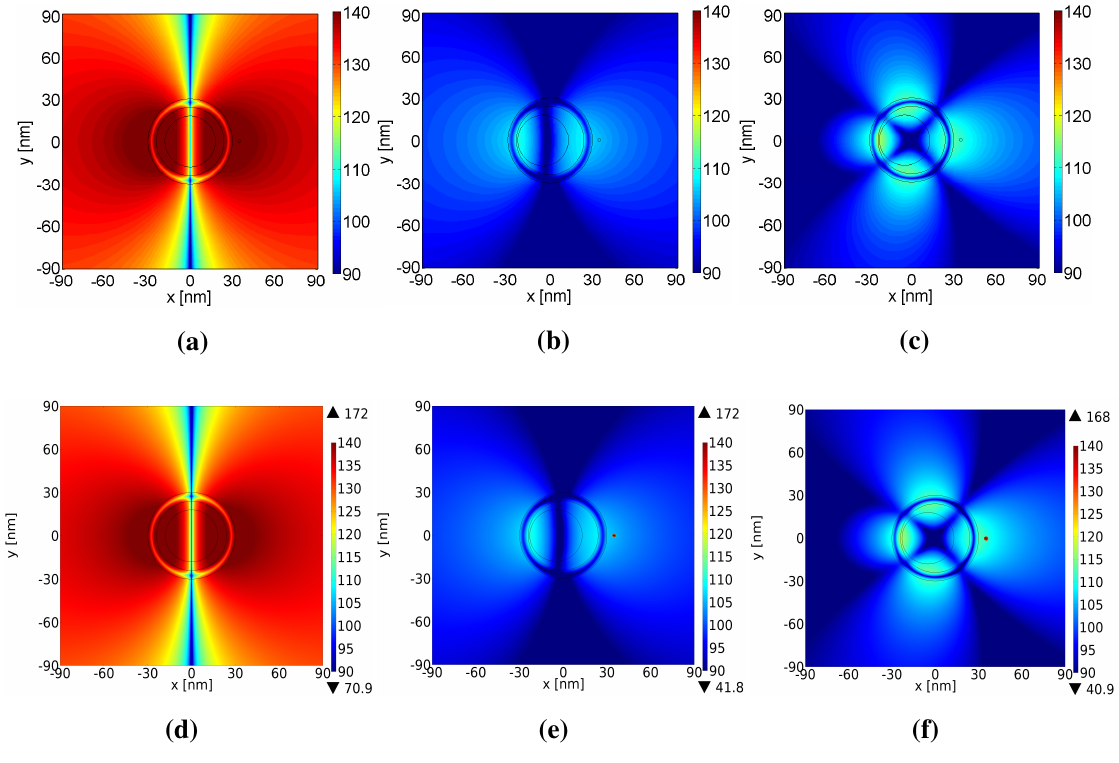
| H | , for the examined 3L NPs. All 10 = − 5 13